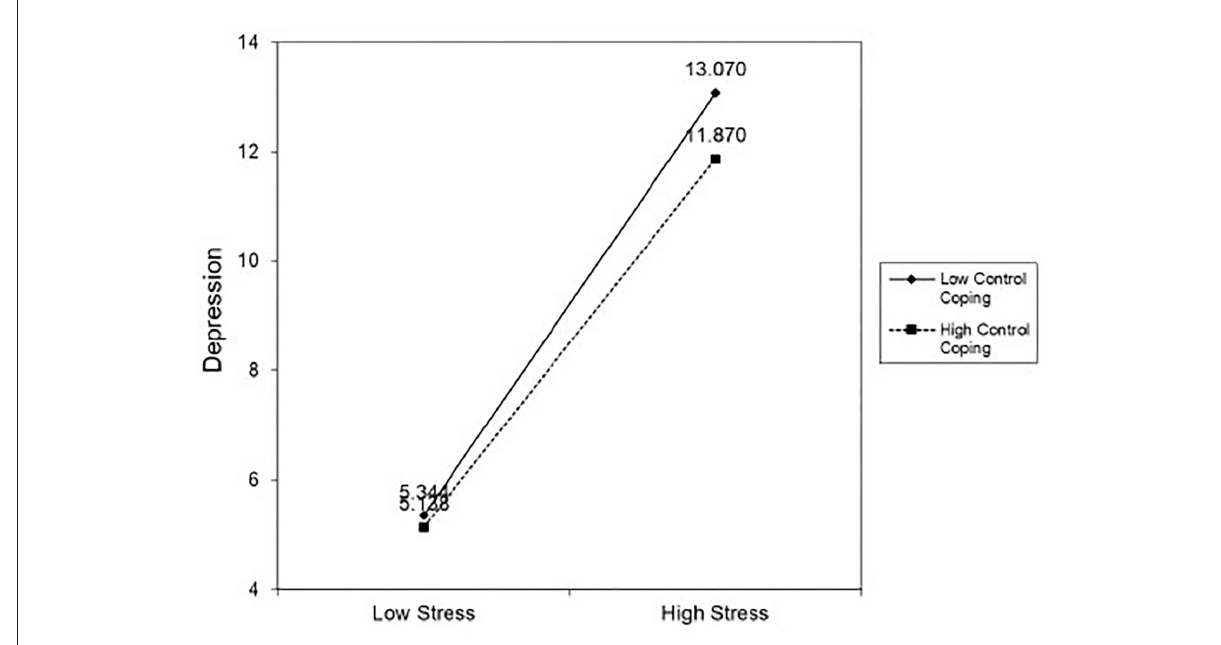
FIGURE1 The moderating effect of control coping on the relationships between job stress and